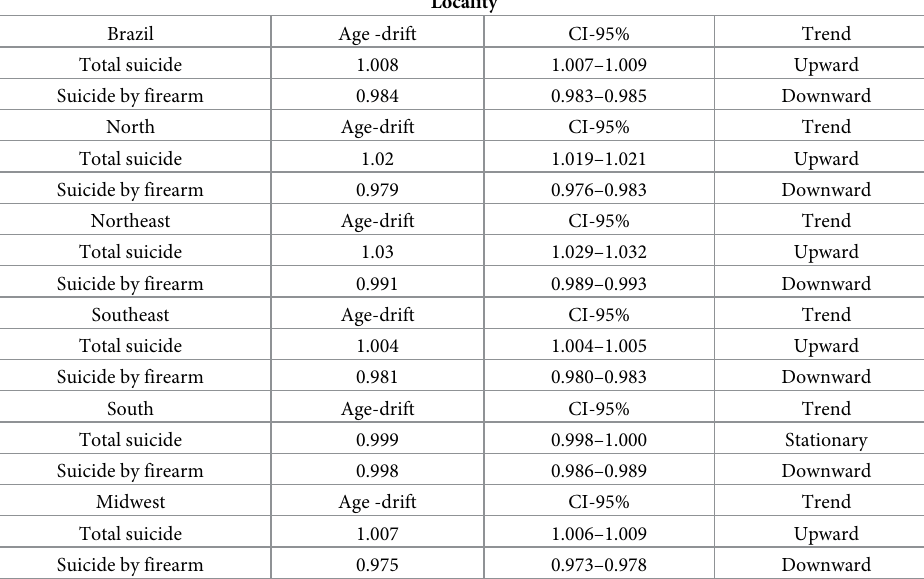
Table 5. Linear age-drift trend for Brazil and its geographic regions after fitting the APC model by estimable functions.